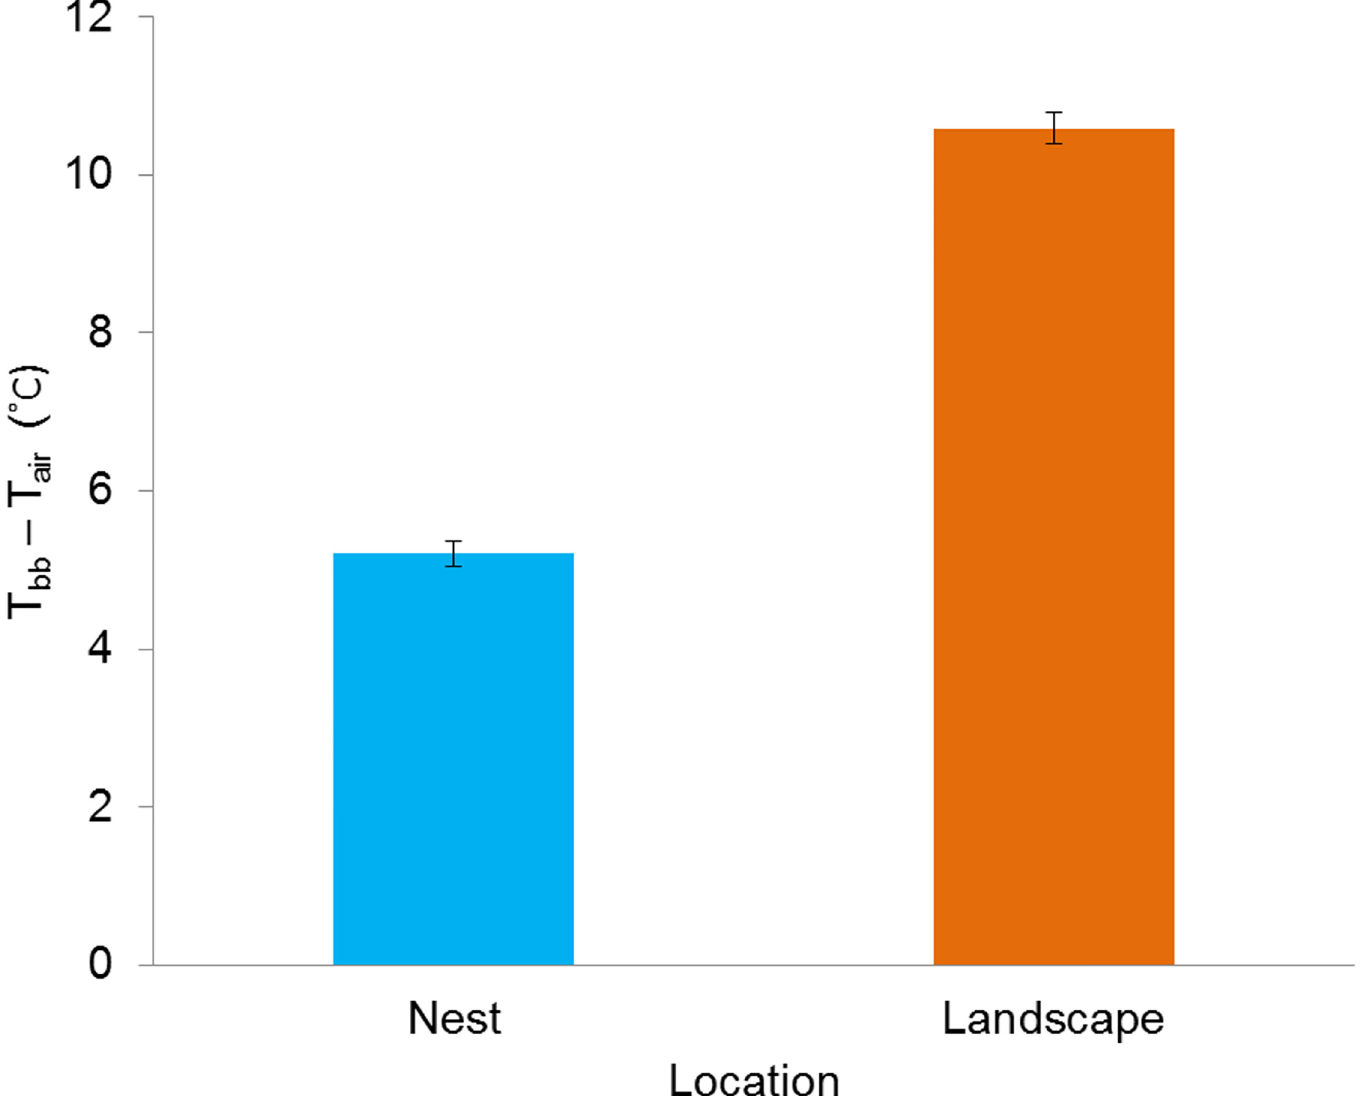
Fig 2. Nest sites substantially decouple thermal environments from the landscape through reduced amplification of heat loads. Differences